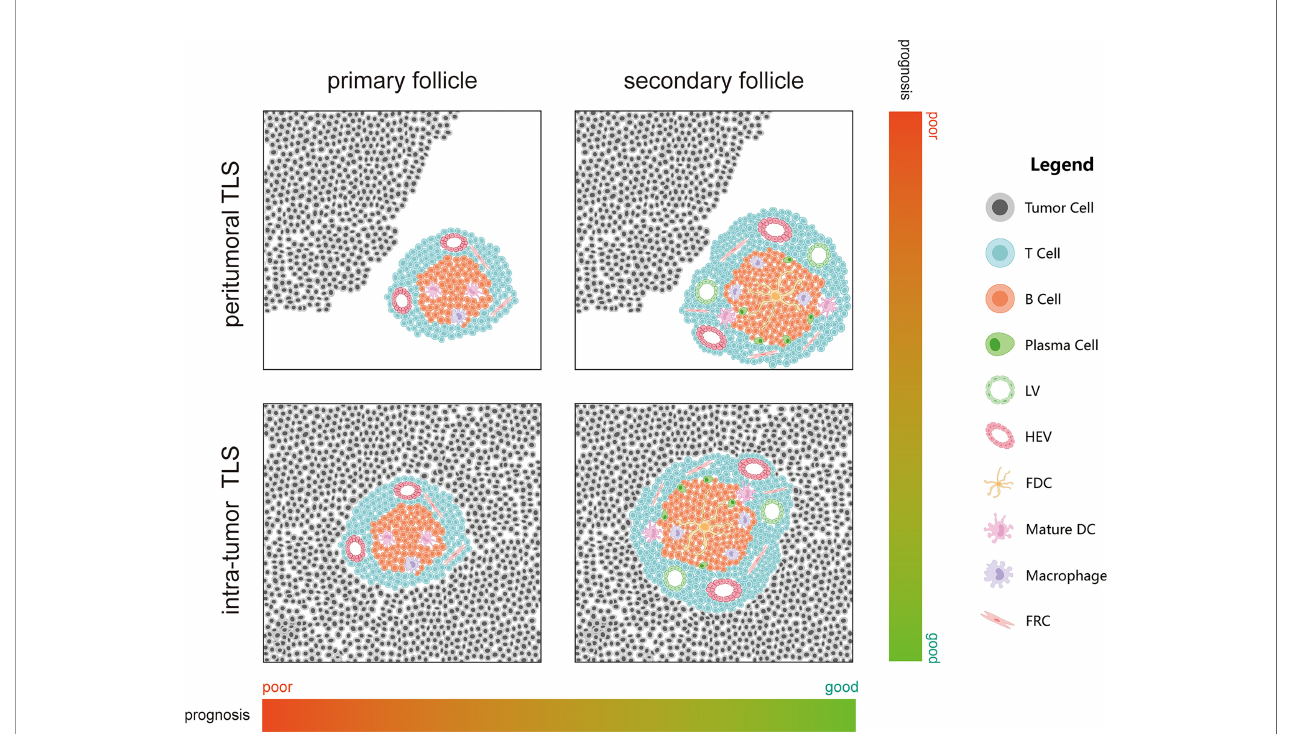
FIGURE 2 | Effect of maturation and location of tertiary lymphatic structures on cancer